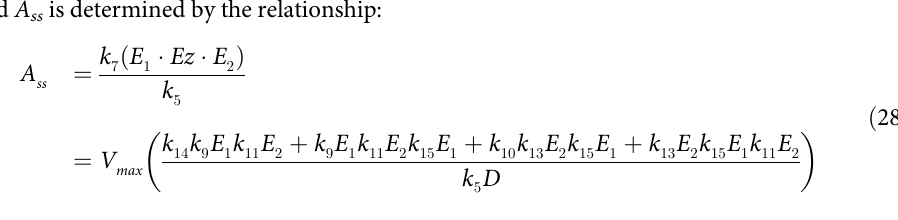
where V = k ( Ez ). D is the sum of all King-Altman numerator terms described in S1 Text. 7 max tot